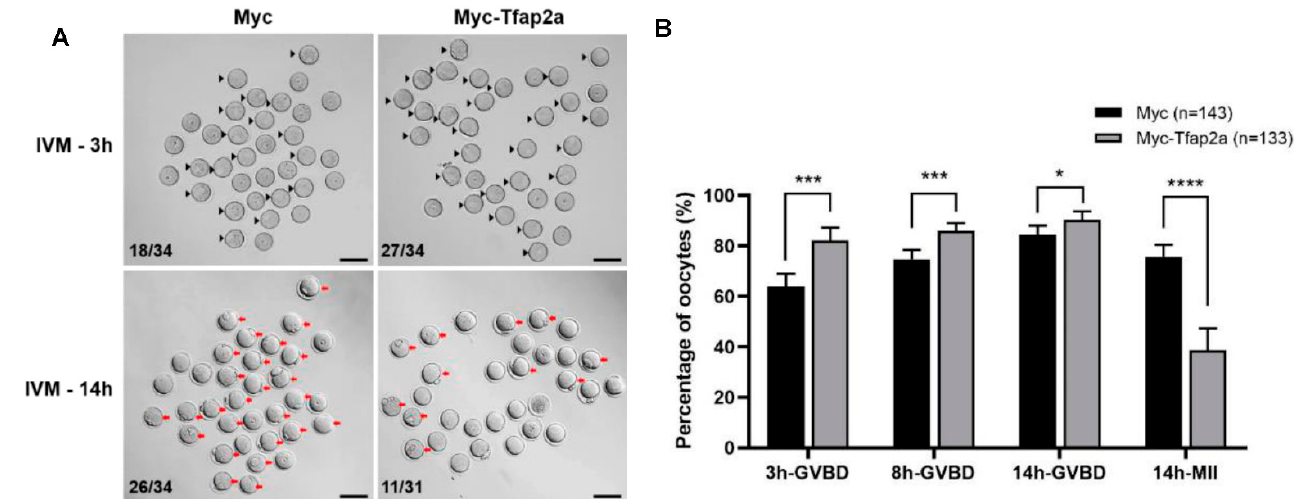
Figure 4. Overexpression of Tfap2a promoted GVBD but inhibited extrusion of the first polar body in mouse oocytes. ( A ) Images of Myc and Myc-Tfap2a mRNA-injected oocytes at different times after maturation in vitro . The arrowheads indicate the GVBD oocytes 3 h after IVM, whereas the red arrows indicate the oocytes with PB1, and the numbers in the images indicate the ratios of GVBD or PB1 extrusion to the total number of oocytes. Scale bar = 100 µm. ( B ) The effects of Tfap2a overexpression on the rates of GVBD and PB1 oocytes at different times after IVM. Data are represented as the mean ± SEM of at least three independent experiments. * p < 0.05, *** p < 0.001, **** p < 0.0001.